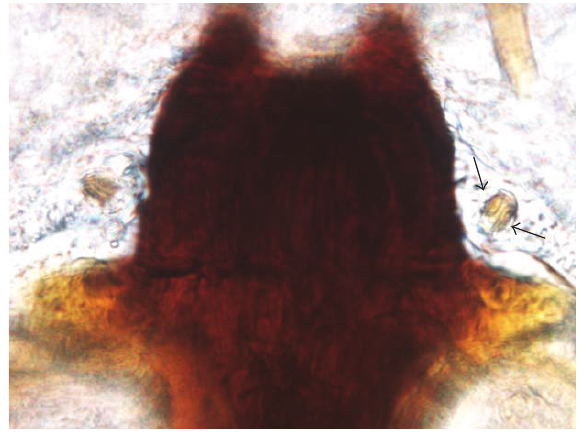
Figure 28: The paired structures within the sternal papillae are extrusible and may be sensory pegs